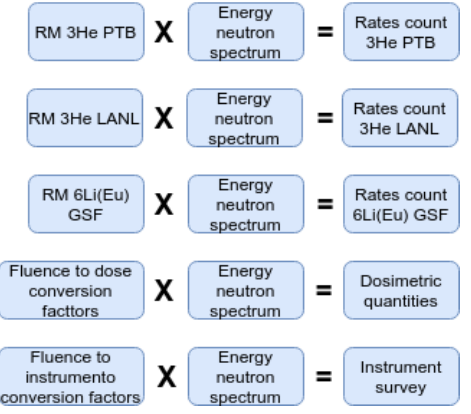
Figure 3. IAEA’s information extraction procedure and calculation of GRANN training data